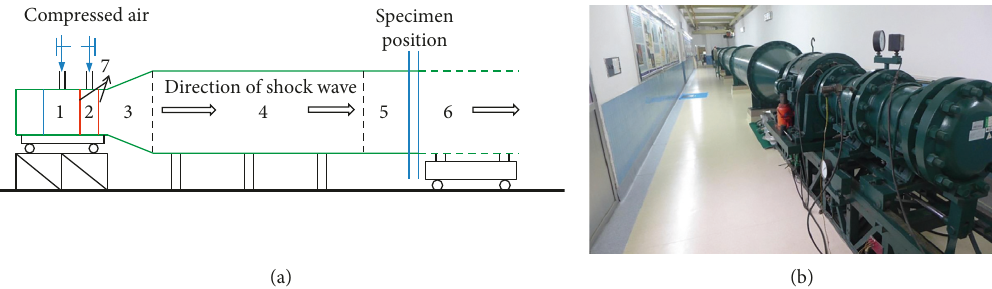
Figure 3: Shock tube device. (a) Schematic diagram of shock tube device: (1) high-pressure driver; (2) dual-membrane mechanism; (3) expansion cone; (4) transition ring; (5) target vessel; (6) dissipation ring; (7) aluminium membrane. (b) Real device.